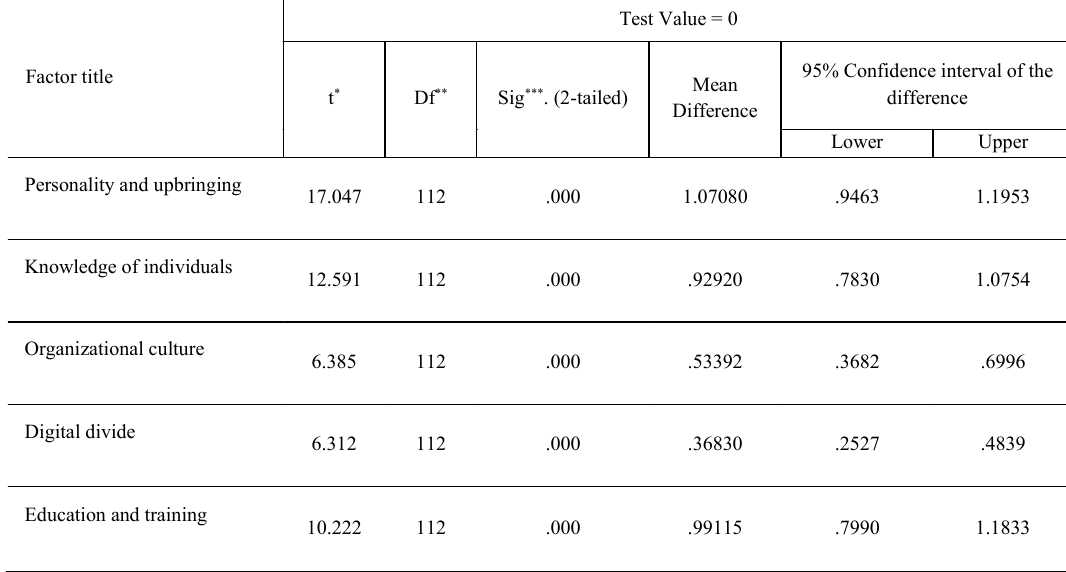
Table 3: One-Sample Test of hypotheses